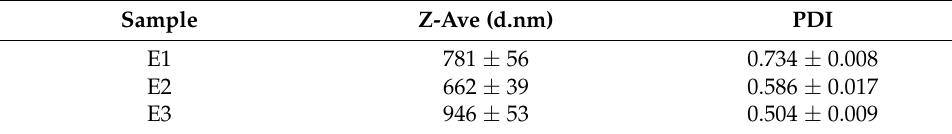
Table 4. Particle size and polydispersity index (PDI) of samples